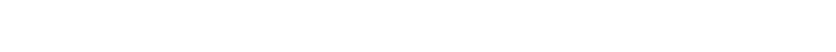
FIGURE 1 | Unadjusted Kaplan–Meier survival among black patients by β -blocker discharge status